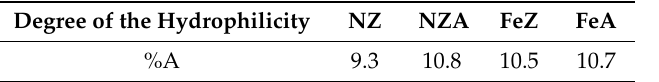
Table 4. %A for NZ, NZA, FeZ,